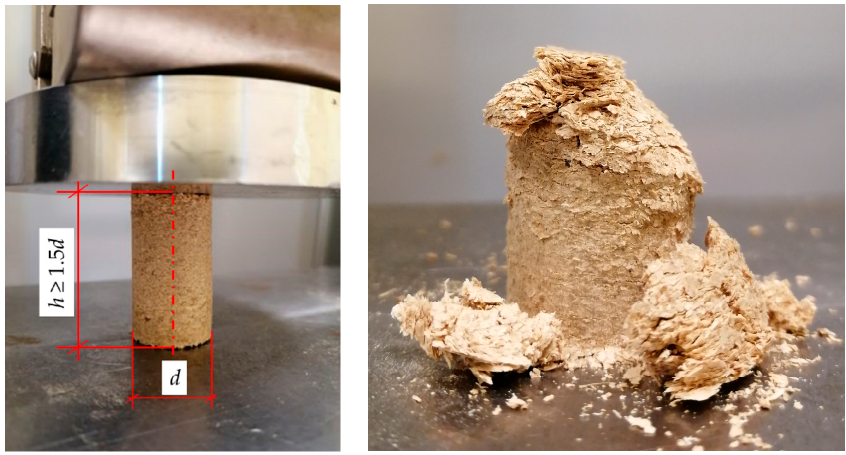
Figure 5. General view of the compacted sawdust sample to be subject to the axial compression force F c (on the left), and a view of the destroyed sample (on the right).